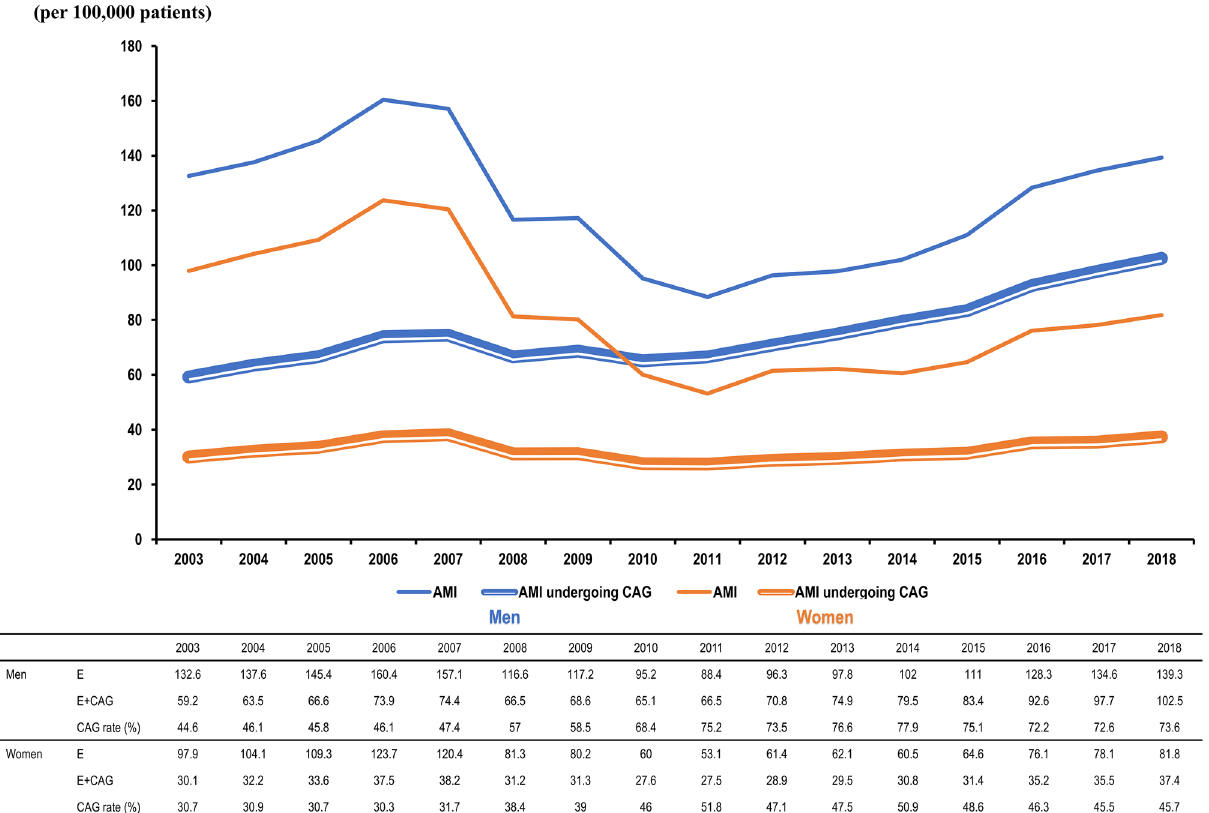
Figure 2. Incidence of AMI and CAG rate from 2003 to 2018 according to the Korean National Health Insurance Claims Database. The CAG rate was defined as the proportion of patients diagnosed with AMI who also underwent CAG compared to the number of patients diagnosed with the disease. Since 2003, fewer women with AMI have undergone CAG than men, with a more prominent gender gap. Abbreviations: AMI, acute myocardial infarction; CAG, coronary angiography; E, cardiac enzyme.